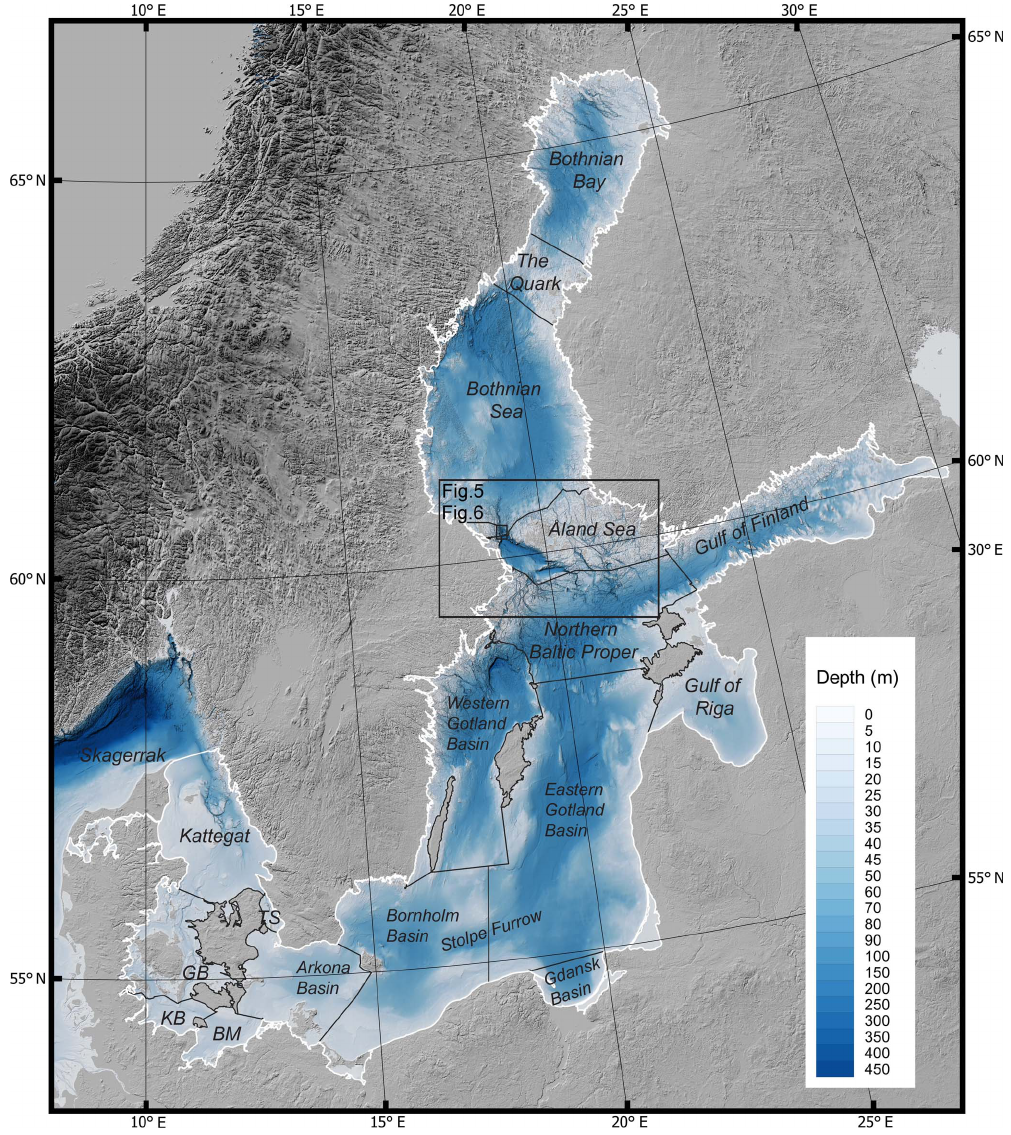
Figure 1. Bathymetric map of the Baltic Sea based on the EMODnet 2018 DBM. The HELCOM-adopted outer limit of the Baltic Sea is shown with a white line and borders between 17 HELCOM-defined sub-basins are shown with black lines. BM is Bay of Mecklenburg; GB is Great Belt; KB is Kiel Basin; TS is the